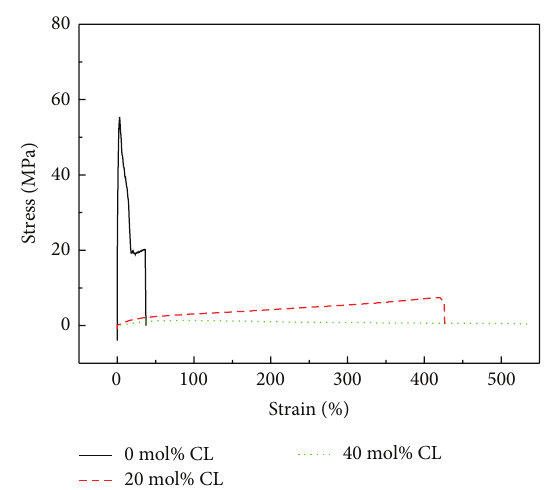
Figure 5: The weight loss of PLGC copolymers in vitro as a function of degradation